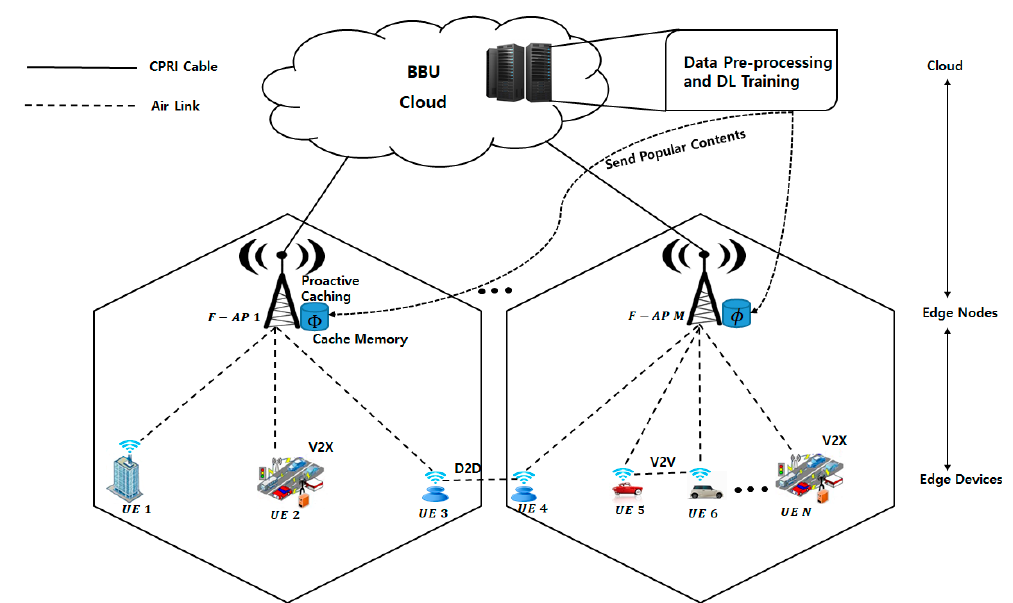
Figure 2. DL-based content caching in the fog-access points (F-APs).